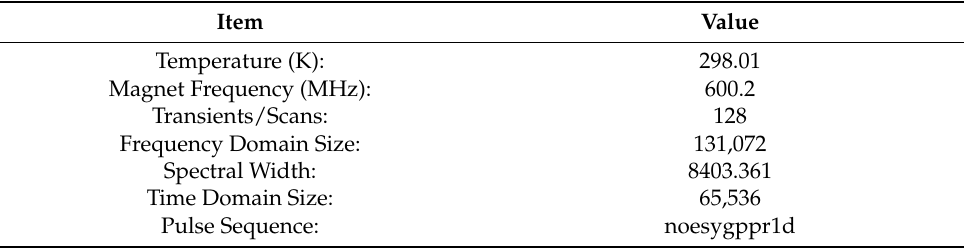
Table 2. Parameters of